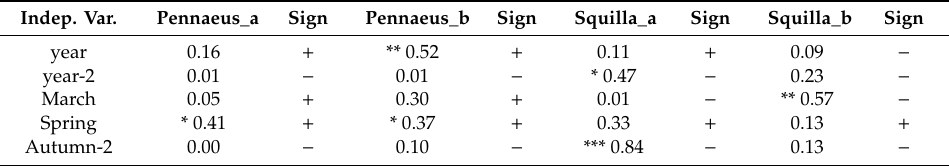
Table 9. Coe ffi cients of determination (R 2 ) and signs of coe ffi cients of general linear models (GLMs) developed using the selected fishery taxa and technique (a: trawling; b: other techniques) as the dependent variable and flows averaged along di ff erent periods as the independent variables (“Indep. var.”; “-2” indicates that it is the value from two years ago), through a stepwise selection procedure. Only variables with relevant results are shown. Indep.